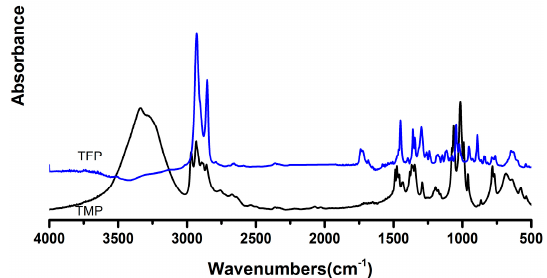
Figure 3. FT-IR Spectrum of the comparison between trimethylolpropane (TMP) and TFP: the peaks of furoic groups were showed at 1734 cm − 1 (C=O bonds stretching), 1297, 1181, and 1117 cm − 1 (furan rings stretching), 1449 and 1350 cm − 1 (C=C bonds stretching), 1238 and 1045 cm − 1 (C–O–C bonds stretching), and 763 cm − 1 (furoic C–H bonds out-of-plane bending).